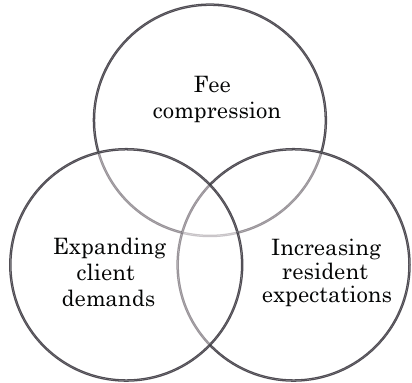
Fig. 1. Factors encouraging third-party apartment management firms to refine their approach to business development and client